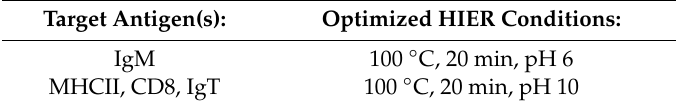
Table 2. Optimized heat-induced epitope retrieval (HIER) treatment of tissue sections for each antigen. Target